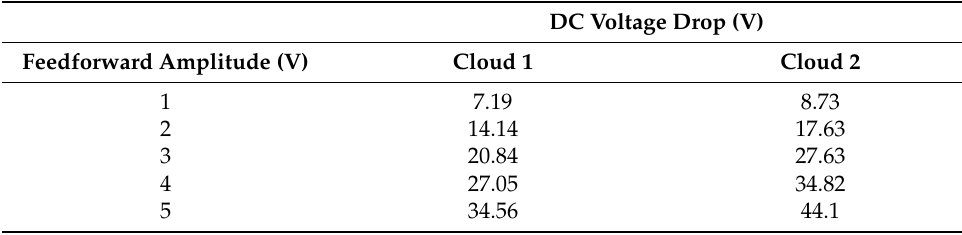
Table 1. DC voltage drop with different cloud signal